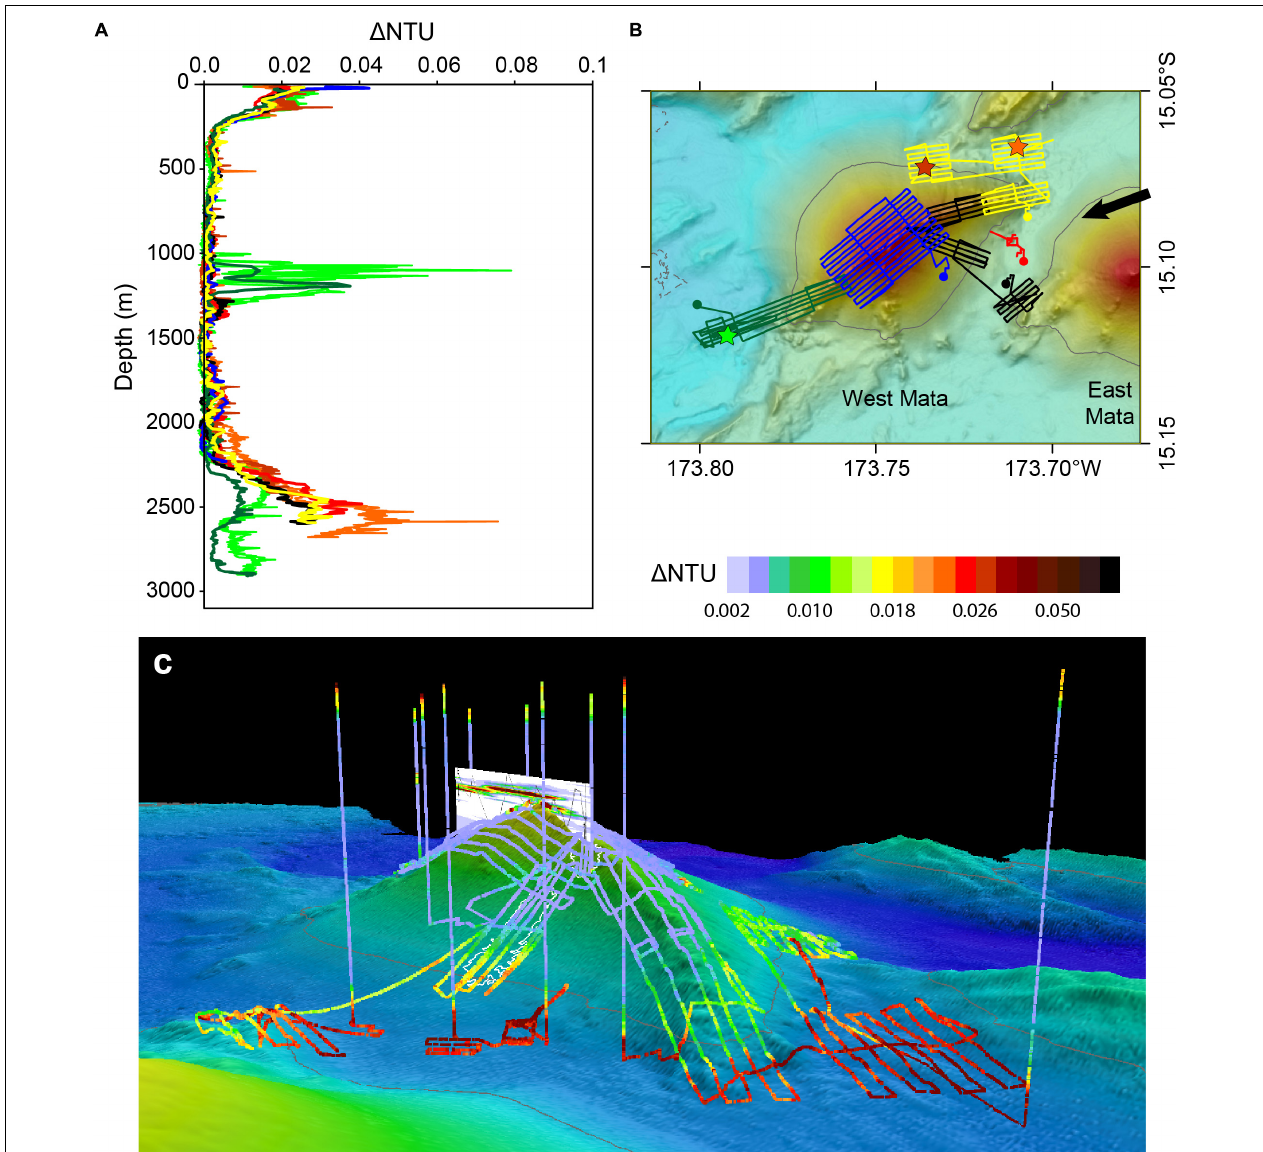
FIGURE 7 | MAPR data from AUV Sentry dives. (A) MAPR (cid:49) NTU profiles compared to similarly located CTD profiles; (B) map with Sentry tracklines. Dots show MAPR profile locations (initial descent for each Sentry dive), stars show CTD locations. Colors in (B) match profile line colors in (A) ; (C) 3-d image of MAPR (cid:49) NTU at 70 m above bottom during Sentry dives viewed from the northeast (arrow in B shows orientation for this view). The 2016–2017 new deposit is outlined in white on the SE slope of West Mata. Vertical panel above the summit of West Mata shows the plume above the summit (CTD tow T17B-01) dispersing toward the southwest. See also Supplementary Movie S1 for a virtual tour of the plumes surrounding West